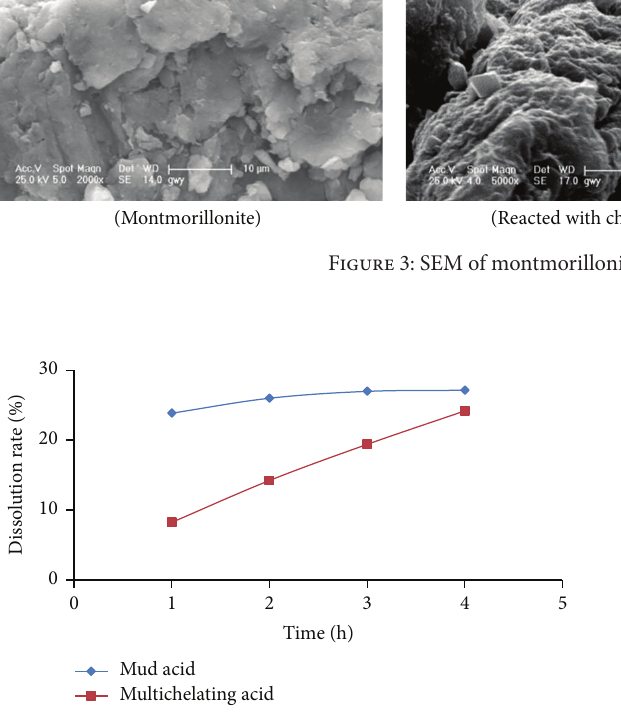
Figure 4: Rock-powder dissolving rate with mud acid and multi- chelating